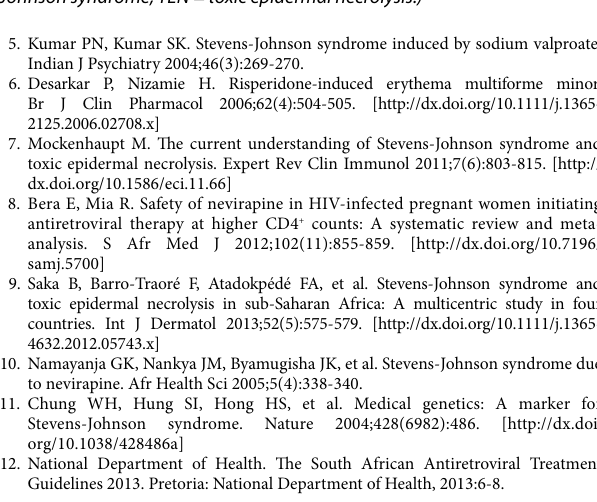
Fig. 1. Severe SJS/TEN affecting trunk and upper limbs. (SJS = Stevens- Johnson syndrome; TEN = toxic epidermal